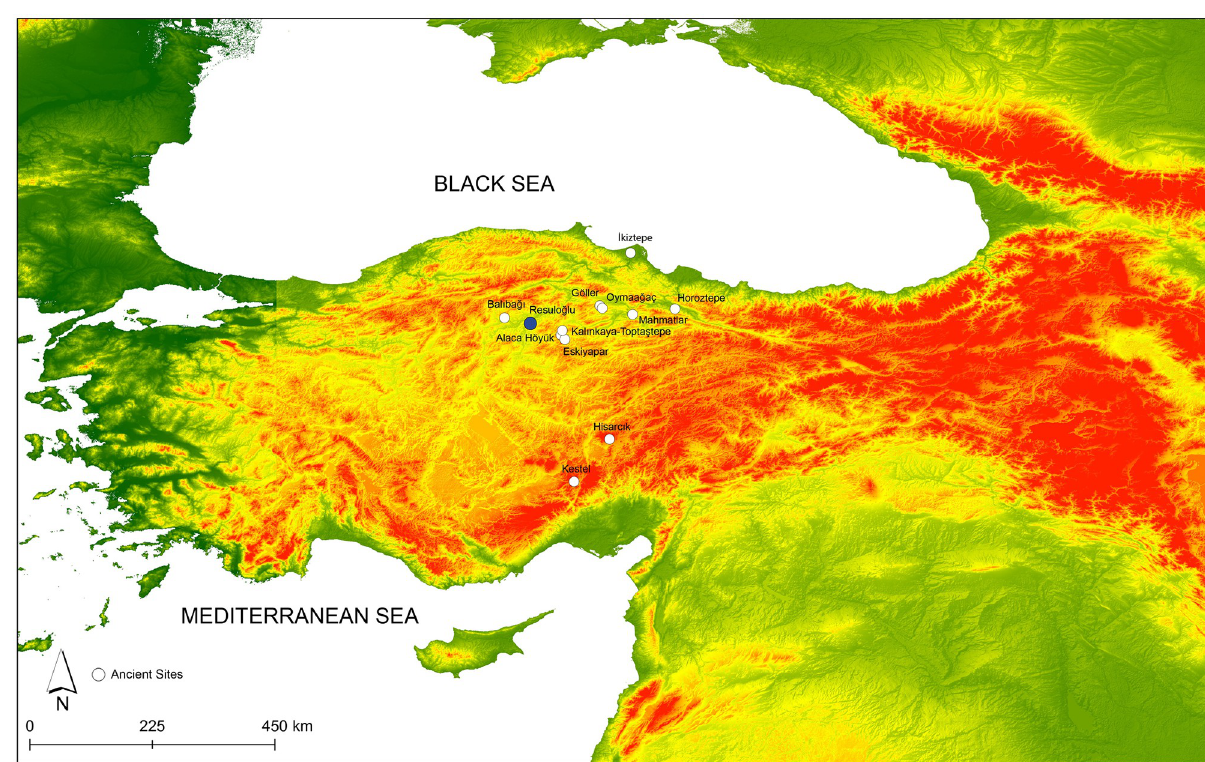
Fig 1. Map of the sites frequently referenced in the article. Resulo ğ lu is labeled in blue (map created by D. Yazıcı and Dardeniz).